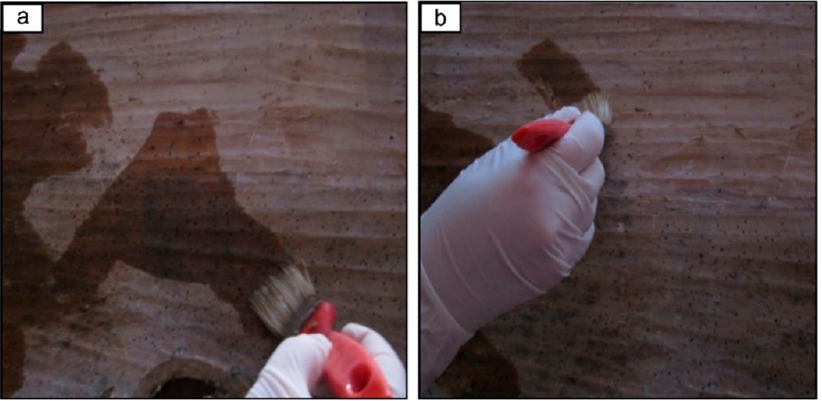
Figure 3. Preventive treatment against xylophagous attack by brushing with 2% Permethrin solu- tion ( a , b ).